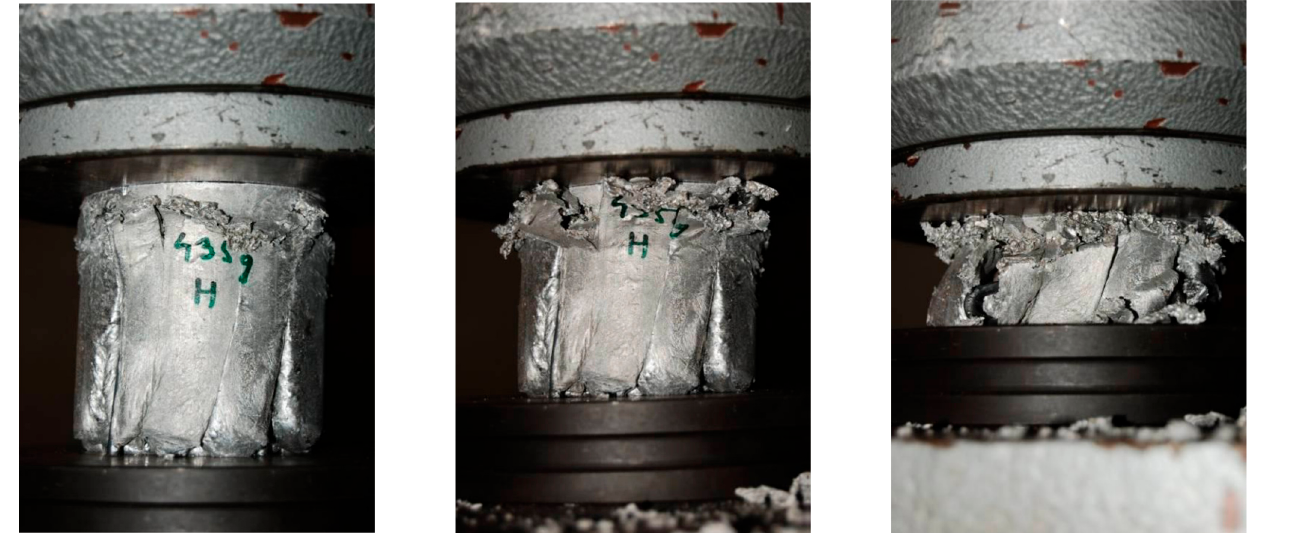
Figure 5. The sample H1 under compression load and irregularities on outer skin.